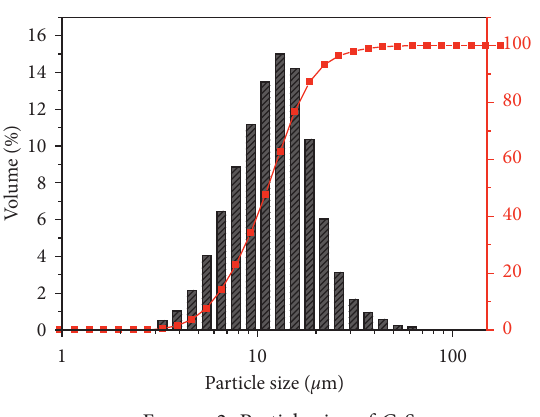
Figure 1: XRD pattern of C